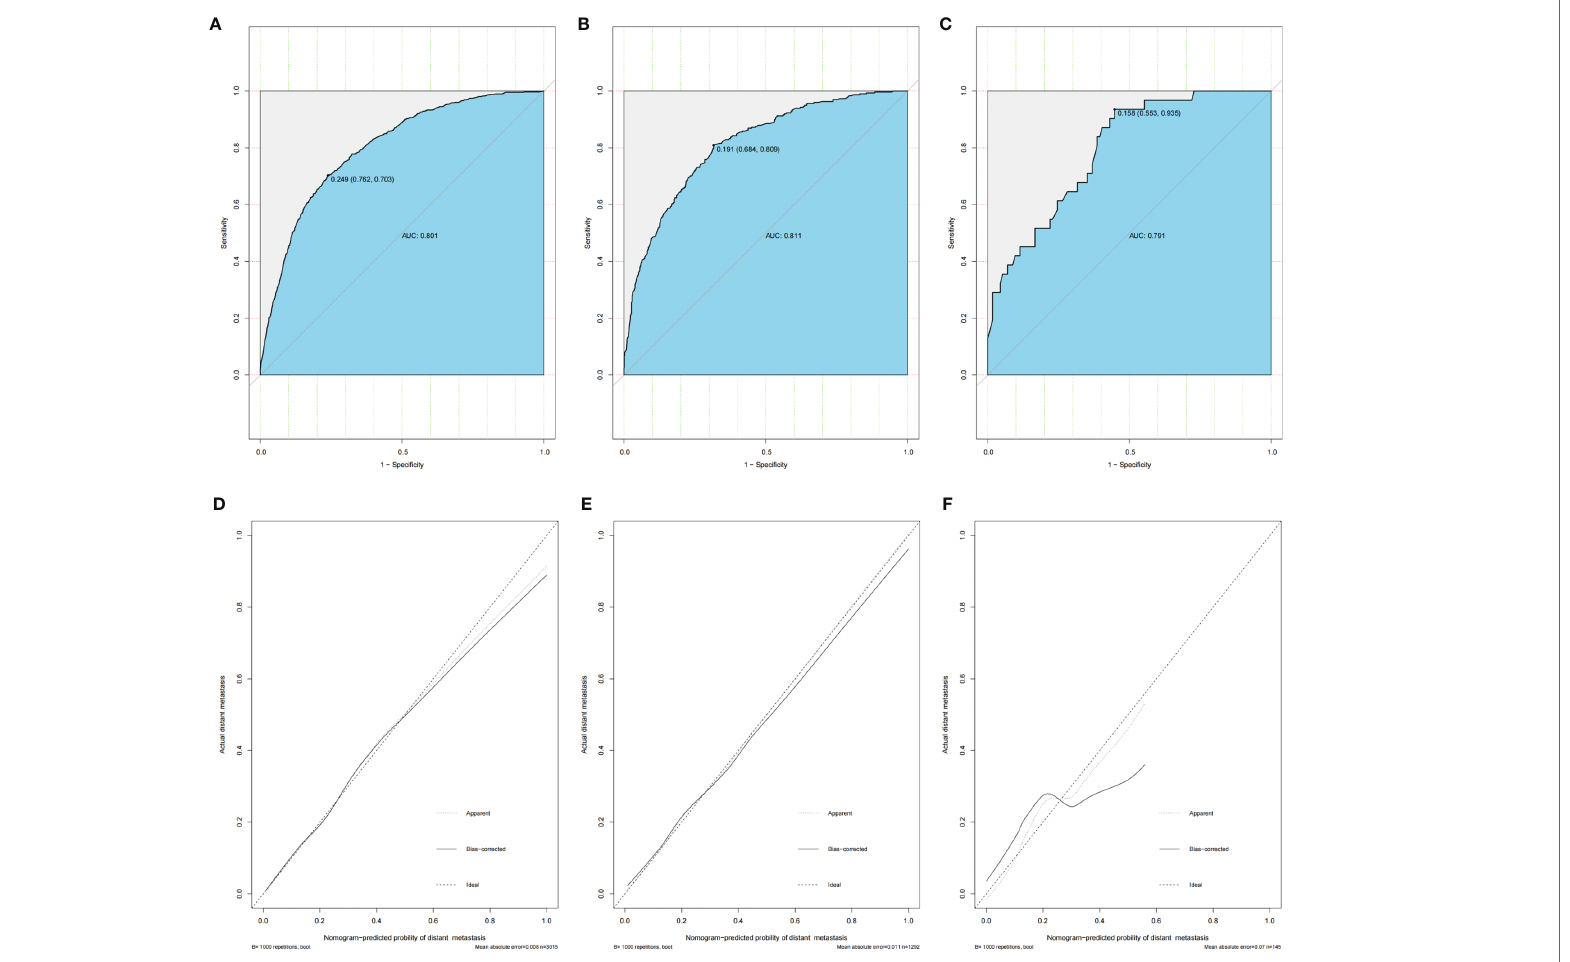
FIGURE 4 | Nomogram ROC curves and calibration curves in training set, testing set, and validation set of advanced stage young-onset colorectal cancer. (A) ROC curve of training set for distant metastasis model (AUC = 80.1%). (B) ROC curve of testing set for distant metastasis model. The AUC is 81.1%. (C) ROC curve of validation set for distant metastasis model (AUC = 79.1%). (D) Calibration curve of training set for distant metastasis model. (E) Calibration curve of testing set for distant metastasis model. (F) Calibration curve of validation set for distant metastasis model. ROC, receiver operating characteristic; AUC, area under the ROC